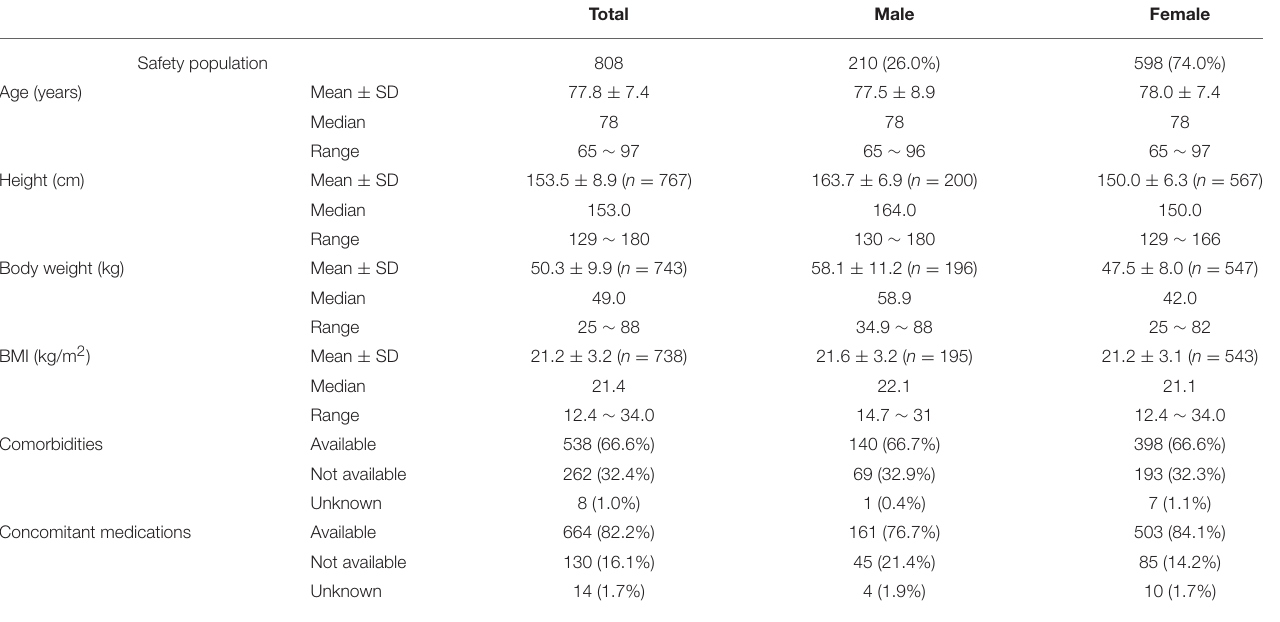
TABLE 3 | Patient